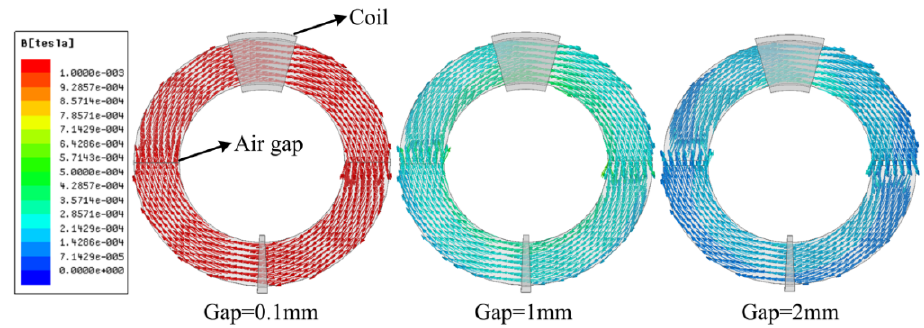
Figure 4. Distribution of the magnetic field of the semi-circle structure core with different air gaps (gap = 0.1 mm, 1 mm, and 2 mm, respectively).